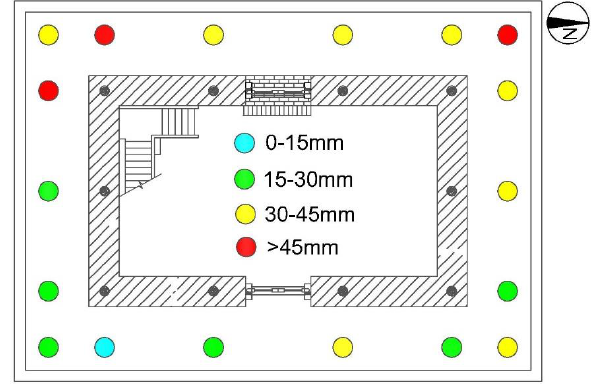
Figure 12. Elevation graph of the columns on the first floor The figure is a plan of the first floor. The circles represent the relative positions of the columns, and different colors indicate the different elevations. Through the figure, we can know that the uneven settlement of the columns of Guanghua Pavilion [ 光 化楼 ] is obvious and the elevation of the columns on the east side is generally lower, while that of the west side is